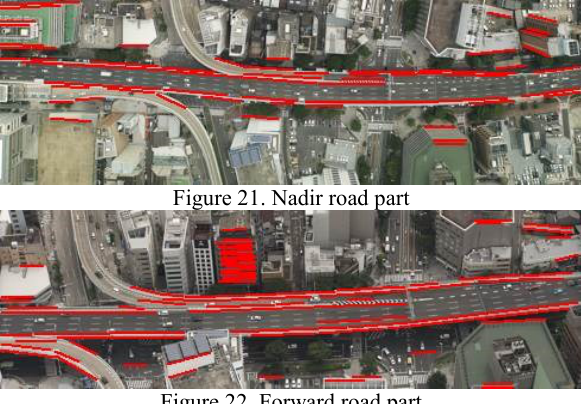
Figure 22. Forward road